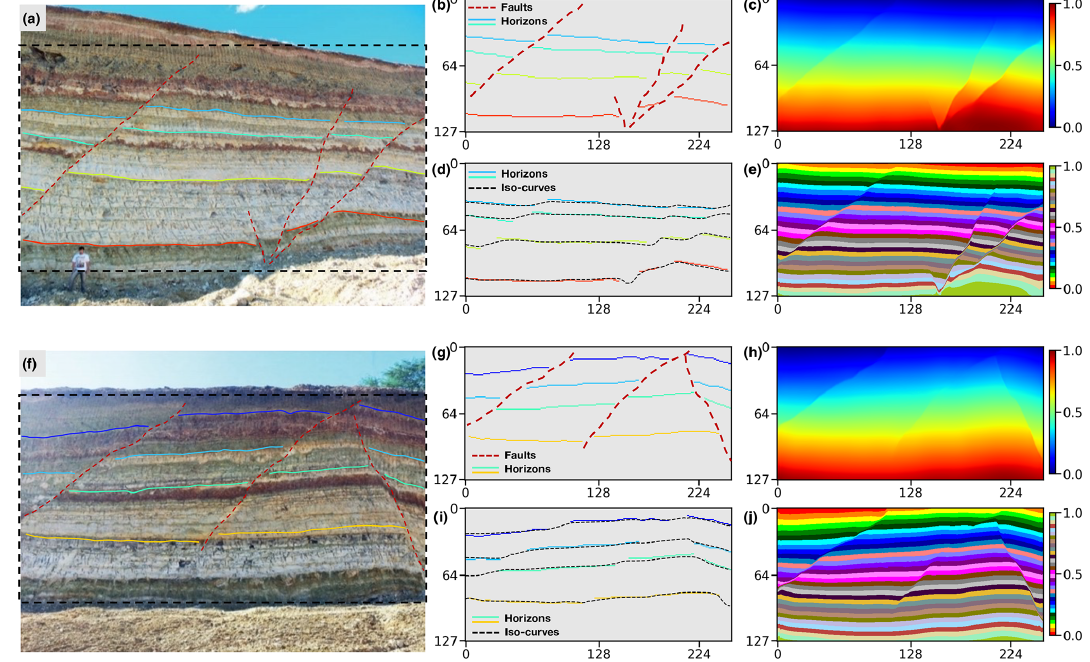
Figure 10. Application in an outcrop field dataset. We display two outcrop images (Fabin et al., 2018) in panels (a) and (f) , input structural data in panels (b) and (g) manually interpreted from the outcrop images within the dashed boxes, predicted structural models using continuous color map in panels (c) and (h) , a discrete color map in panels (e) and (j) , and horizon fitting results in panels (d) and (i) , respectively.